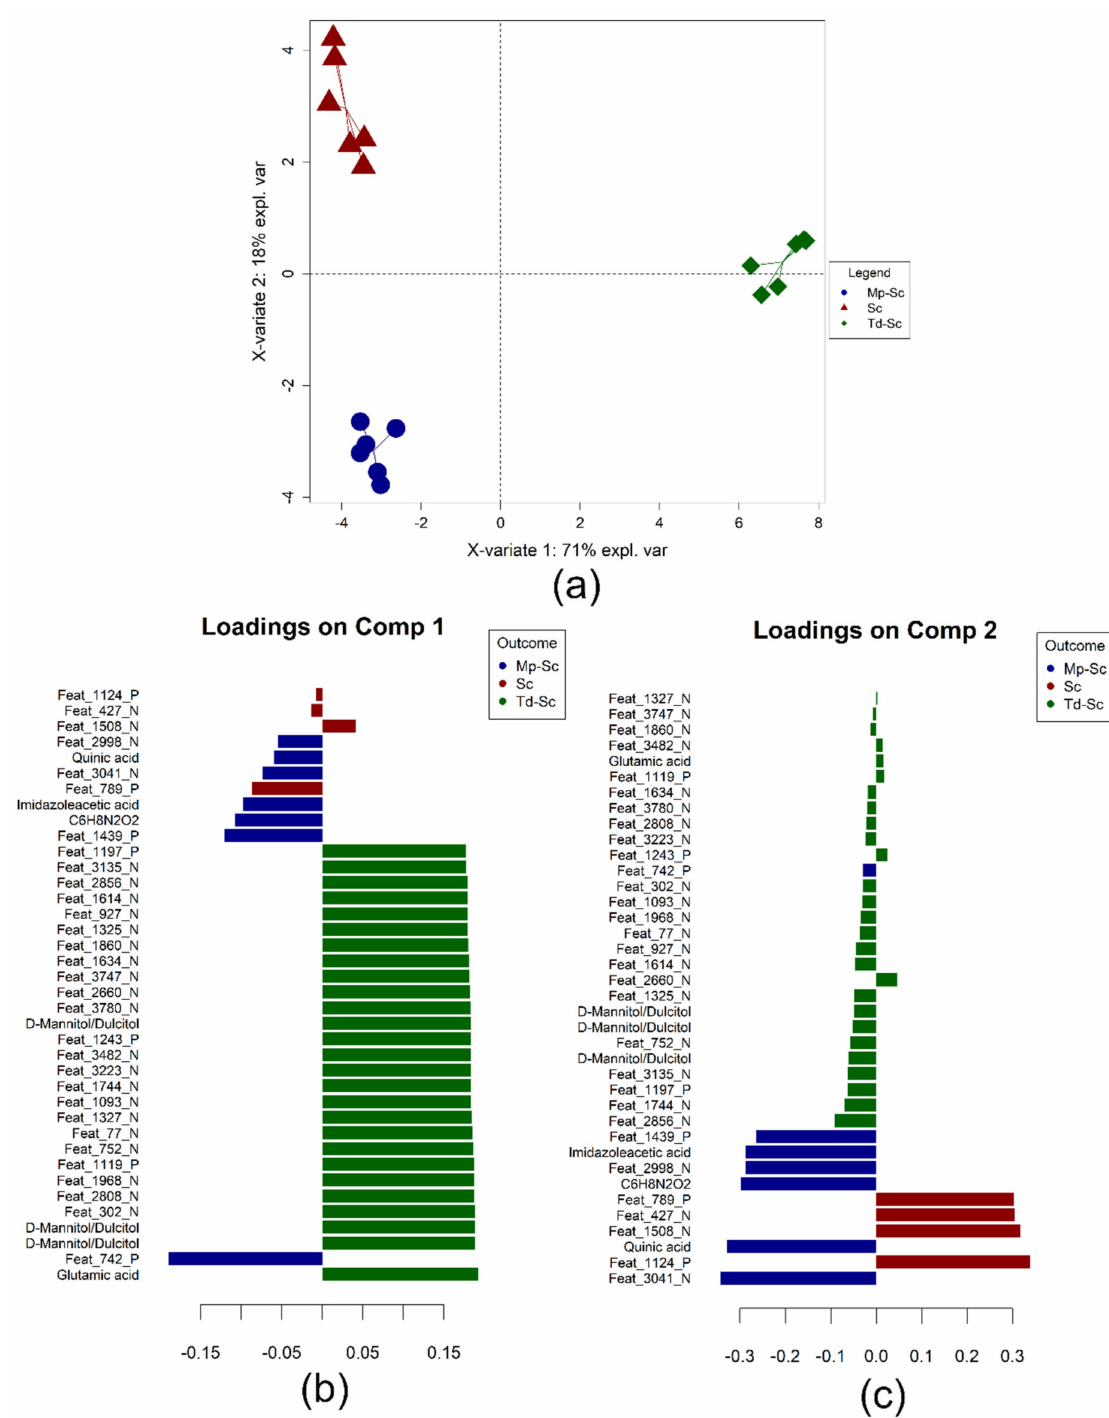
Figure 6. Graphical outputs of the partial least squares discriminant analysis (PLS-DA) performed to classify ros é wines according to the fermentation strategy on the basis of their non-volatile profile. ( a ) Scores plot for the components 1 and 2; ( b , c ) loading contribution barplot on components 1 and 2. Colour indicates the class for which the compound has a maximal mean value. Bar length represents the multivariate regression coefficient with either a positive or negative sign for that particular feature of each component, i.e., the importance of each variable in the model. Sc-Td : wines fermented with sequential inoculation of Torulaspora delbrueckii and Saccharomyces cerevisiae . Sc-Mp : wines fermented with sequential inoculation of Metchnikovia pulcherrima and Saccharomyces cerevisiae . Sc : wines fermented with monoculture of Saccharomyces cerevisiae